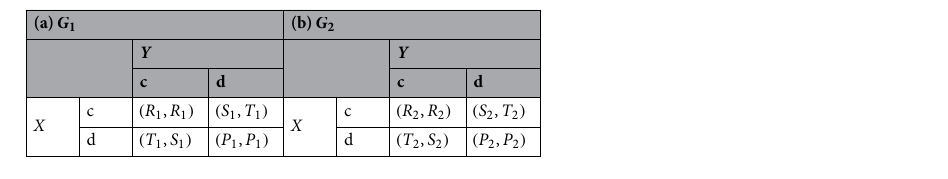
Table 2. Utility matrices in IPD games with